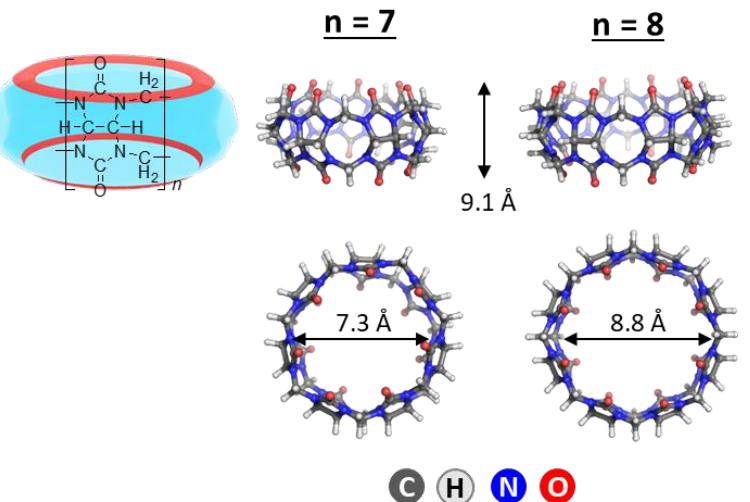
Figure 7. M062X/ 6 − 31G(d,p) optimized structures of CB[7] and CB[8]. The corresponding height and portal diameters are given in Å .